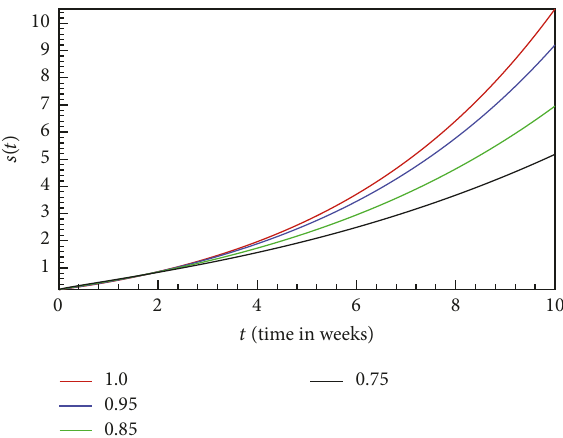
Figure 1: Plot of approximate solutions of susceptible class (𝑠) corresponding to different fractional values of 𝛼 𝑘 for 𝑘 = 1, 2, 3 .